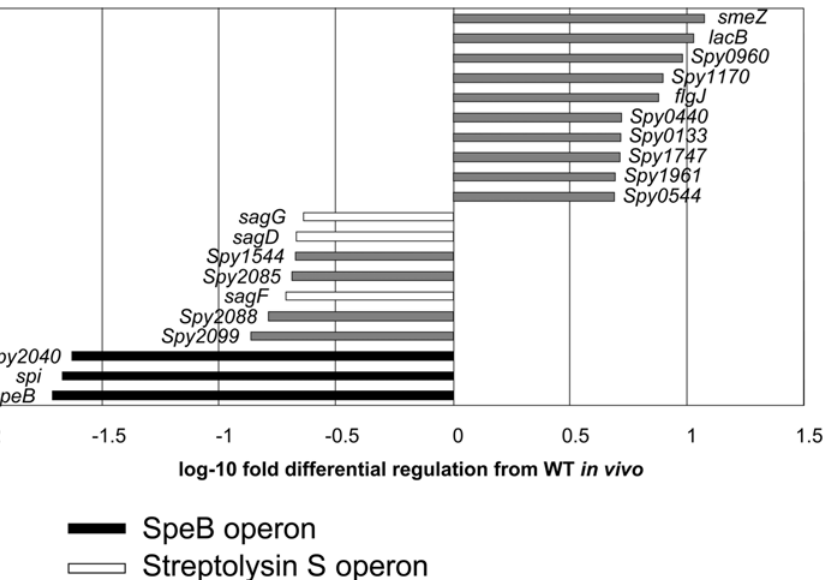
Figure 3. Microarray analysis emphasizes the down-regulation of the SpeB operon. The figure shows the top 10 genes up- and down- regulated in the ropB mutant bacteria compared to WT when the bacteria are inoculated in vivo (P , 0.05). The values plotted represent log ratios (log mutant/WT), and genes co-clustered in operons are highlighted (black bars, SpeB operon; white bars, SLS operon).